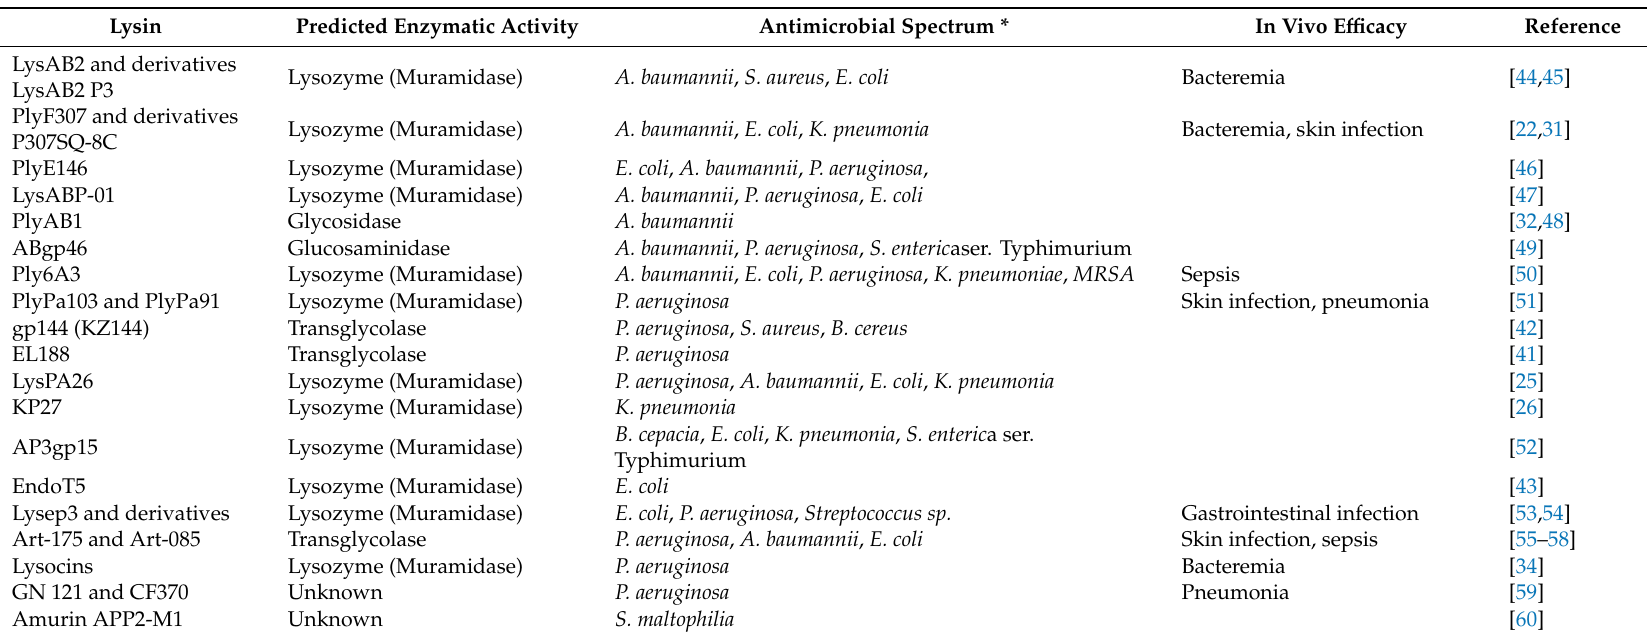
Table 1. Characteristics of Gram-negative